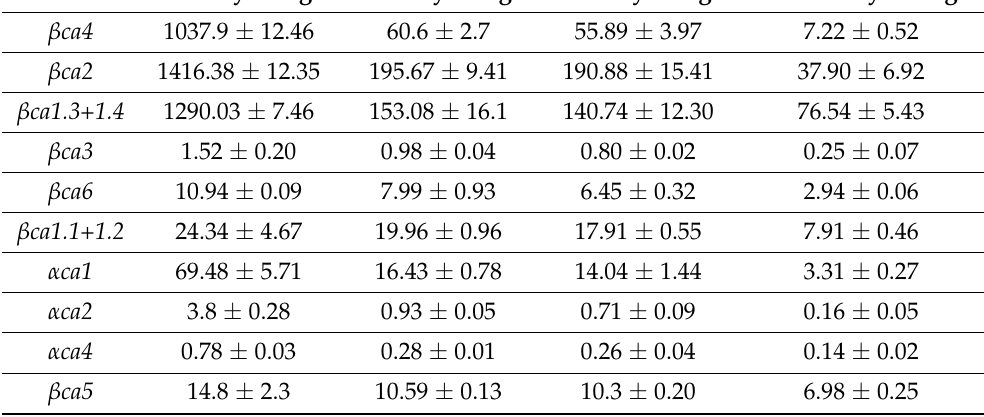
Table 2. Levels of expression of genes encoding CAs in Arabidopsis plants leaves of different ages grown at the CO 2 content of 450 ppm, temperature 19 ◦ C, short day photoperiod 8 h day/16 h night, photosynthetically active radiation of 50–70 µ mol quanta m − 2 s − 1 . Data were normalized for actin gene expression. Data are shown as mean ± the SE of three independent experiments each formed by four repetitions.